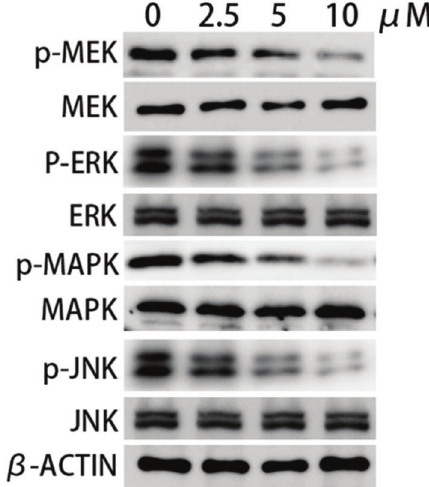
Figure 5. Total and phosphorylated levels of MAPK family mem- bers in MDA-MB-231 cells with distinct doses of cantharidin treat- ment, by western blot. Cantharidin promoted the phosphorylated levels of MAPK signaling pathway. (cid:1) -actin was developed as a loading